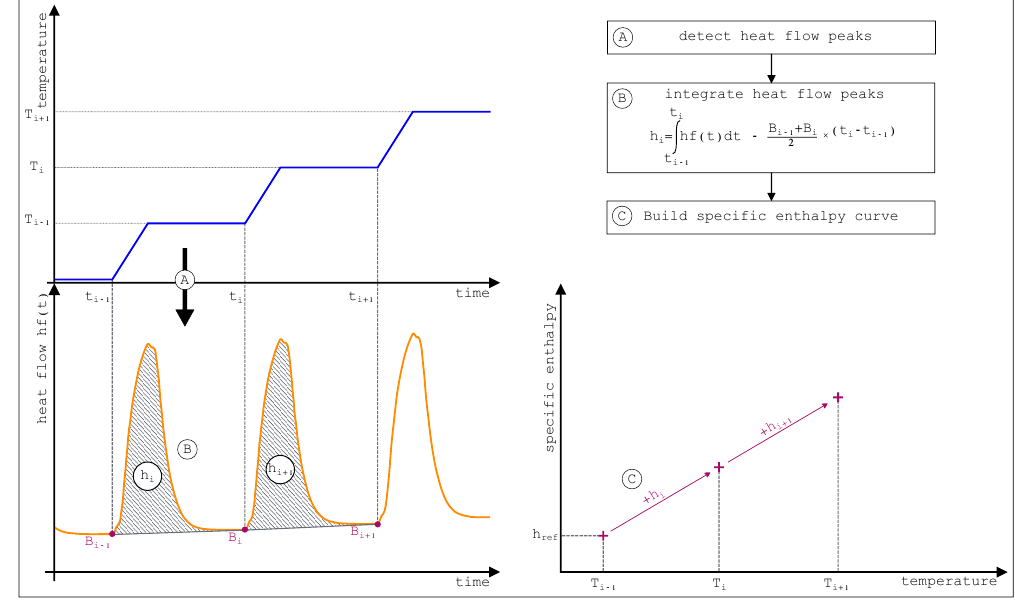
Figure 32. Illustration of the process to build the enthalpy versus time function from STEP method